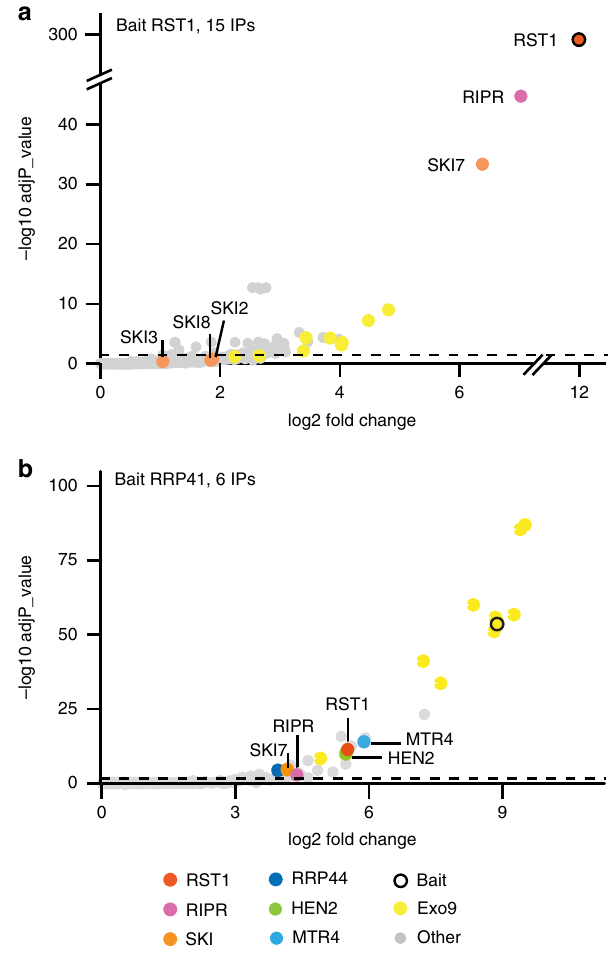
Fig. 4 RST1 co-puri fi es with the exosome, SKI7 and RIPR. Volcano plots show the enrichment of proteins co-puri fi ed with GFP-tagged RST1 ( a ) or RRP41 ( b ) as compared with control IPs. Y - and X -axis display adjusted p -values and fold changes, respectively. The dashed line indicates the threshold above which proteins are signi fi cantly enriched (adjP < 0.05). The source data are available in Supplementary Data 1 and